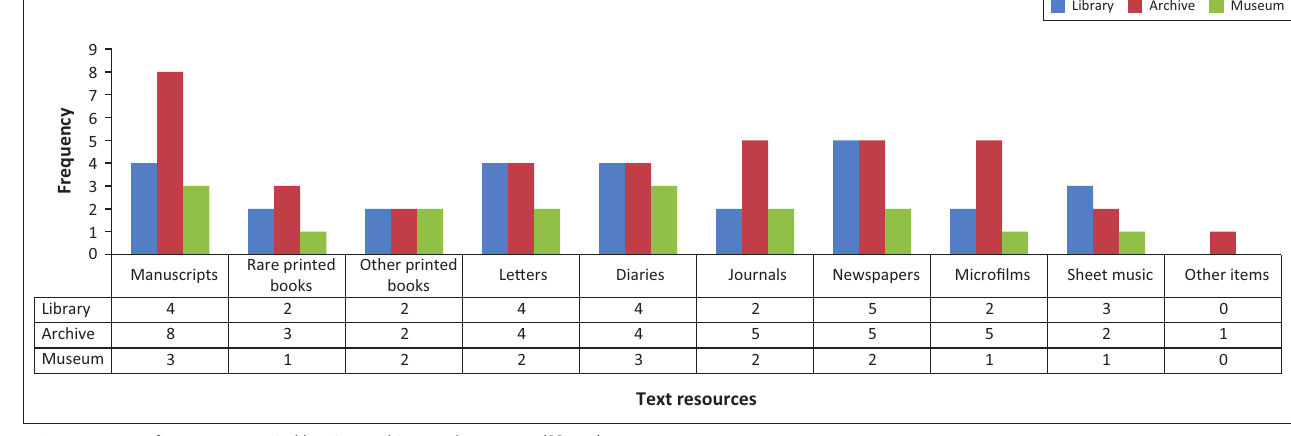
FIGURE 2: Type of text resources in libraries, archives and museums ( N =